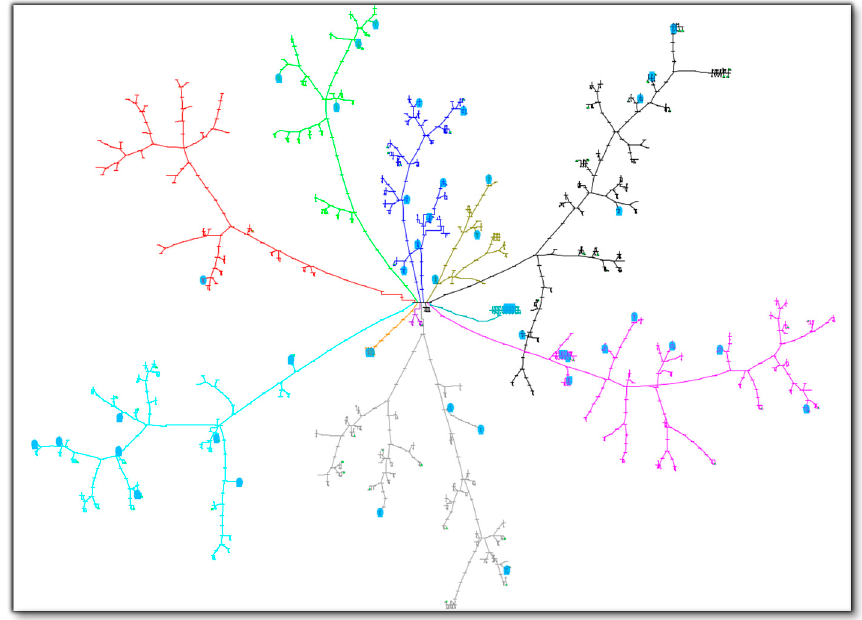
Figure A12. Use case 9—Location of PVs.